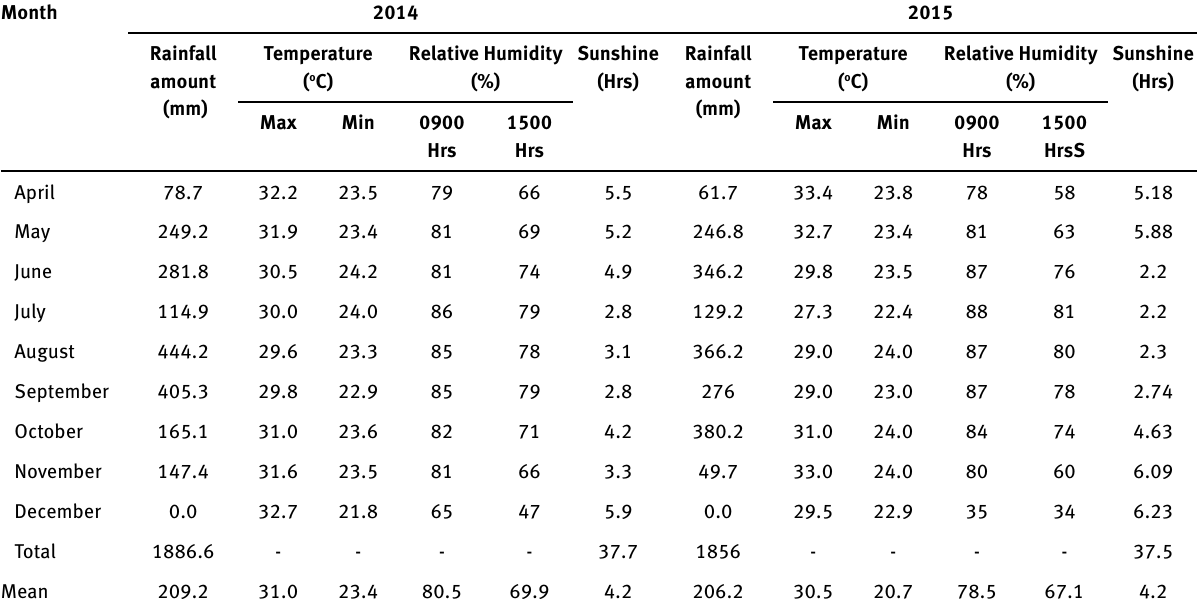
Table 1: Agro-meteorological data of the experimental site in 2014 and 2015 cropping